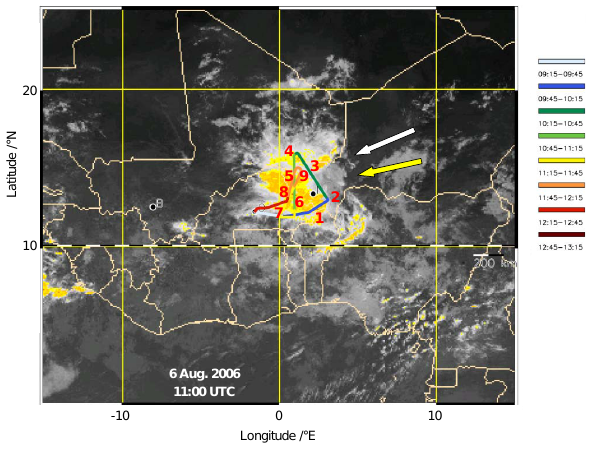
Fig. 2. Meteosat Second Generation (MSG) brightness temperatures over West Africa on 6 August 2006 at 11:00UTC (orange 210K, yellow 225K). Superimposed are the Falcon flight track from Ouagadougou in Burkina Faso (colour-coded according to UTC time) and the sequences with elevated NO mixing ratios ( ≥ 0 . 3 nmolmol − 1 ) labelled 1–9. Capital cities of Mali and Niger are indicated with black dots (B = Bamako to the west, N = Niamey to the east). The white arrow indicates the direction of the storm motion and the yellow arrow the main wind direction in the anvil outflow (not scaled according to velocity).